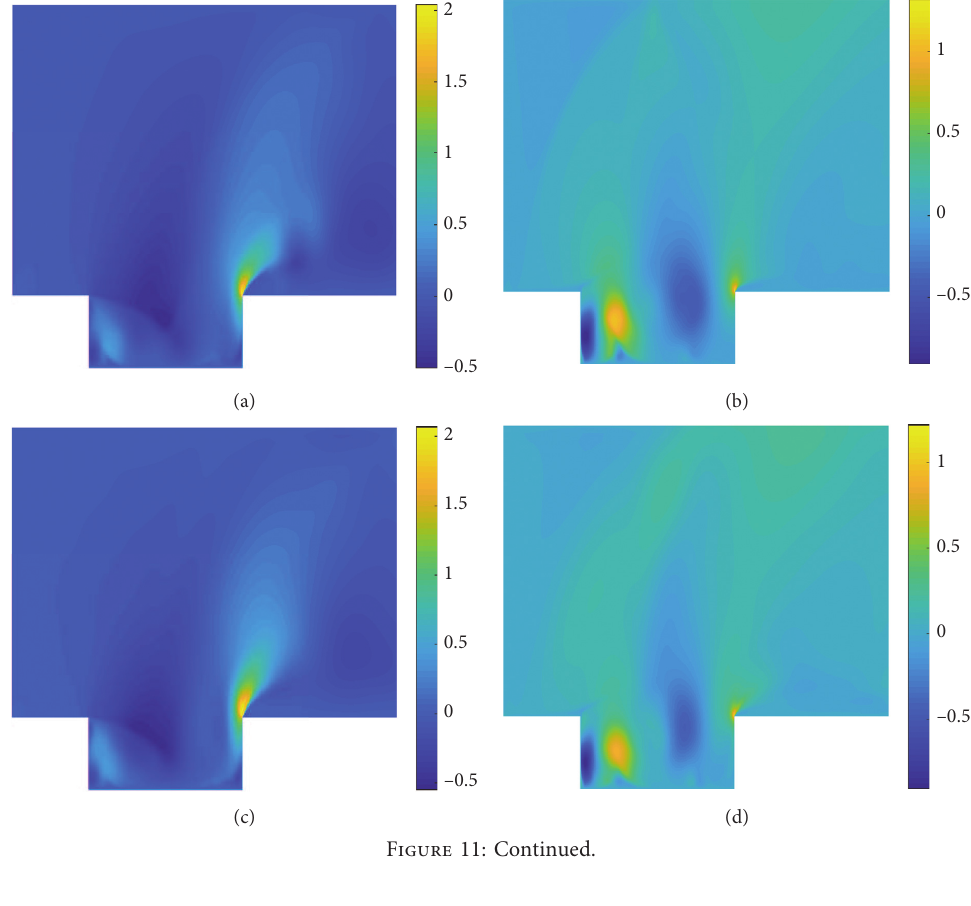
Figure 10: The reconstructed velocity field by DNS and deep learning frameworks at Ma � 0.54. (a) DNS ( tU L � 101.57), (c) MLP ( tU ∞ / L � 98.26), (d) MLP ( tU ∞ / L � 101.57), (e) LSTM ( tU ∞ / L � 98.26), and (f) LSTM ( tU ∞ / L �